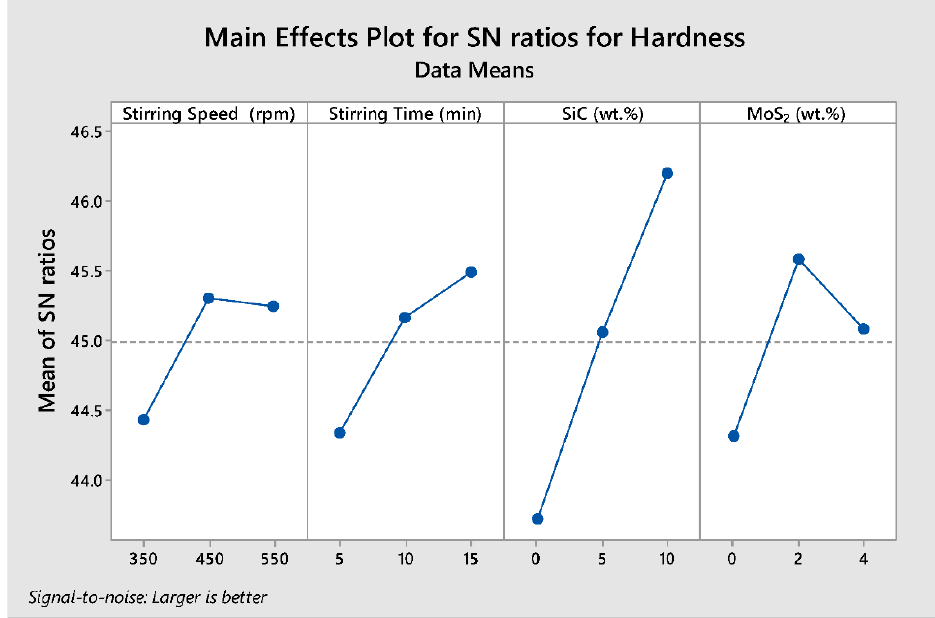
Figure 4. Main effect plots for S/N ratio of hardness.